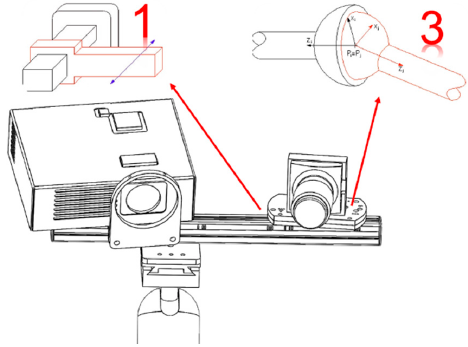
Figure 1. The 3D scanning apparatus and the framework’s degrees of freedom (DoFs). Numbers 1, 2 and 3 indicates the number of DoFs at each joint.